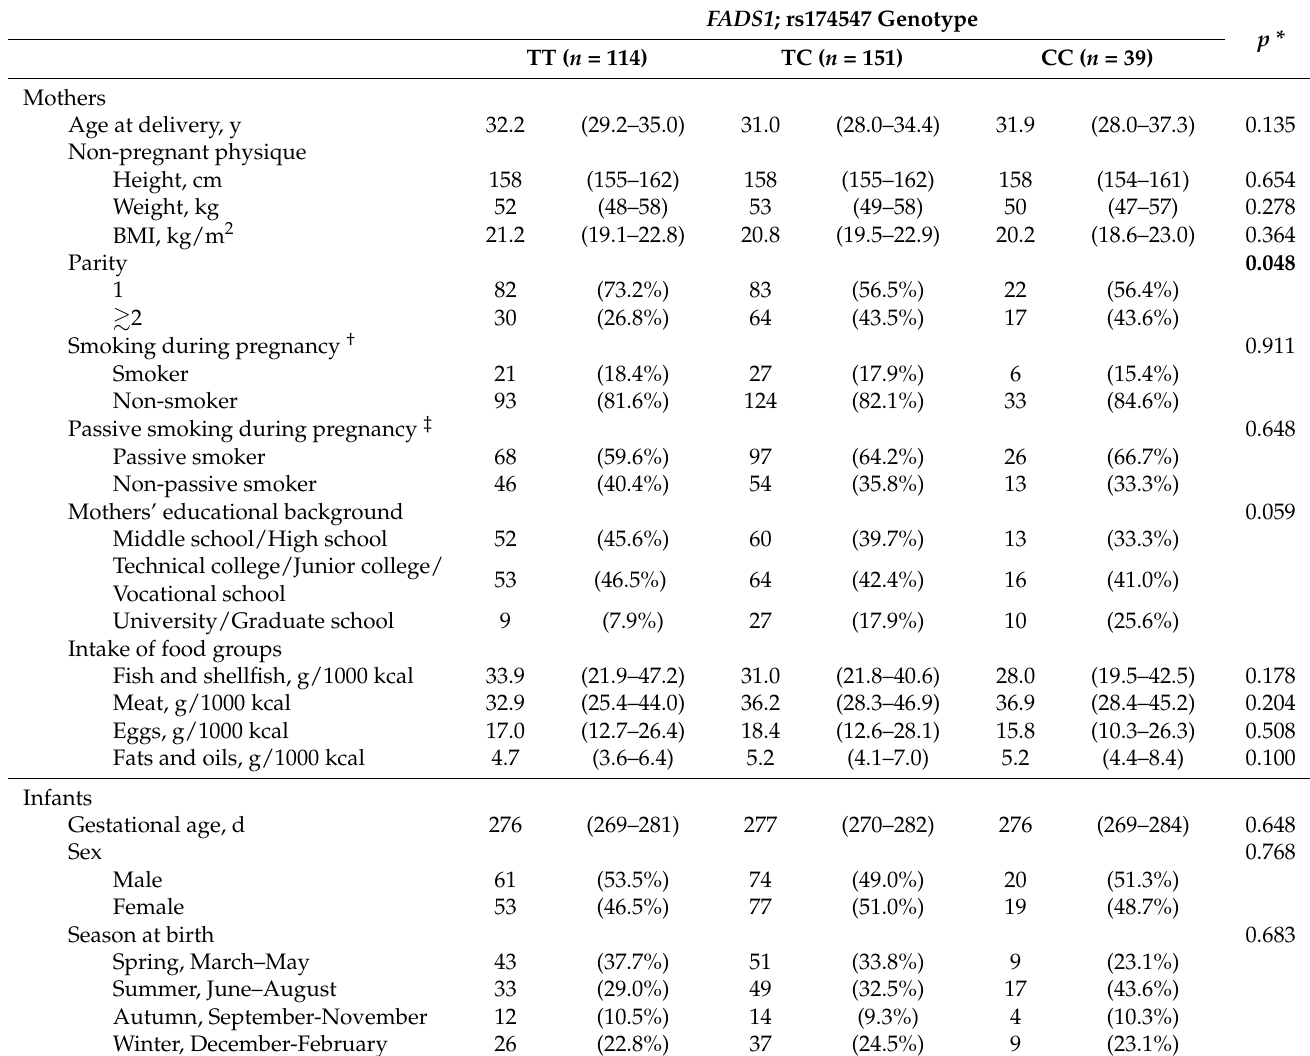
Table 1. Participant characteristics by FADS1 rs174547